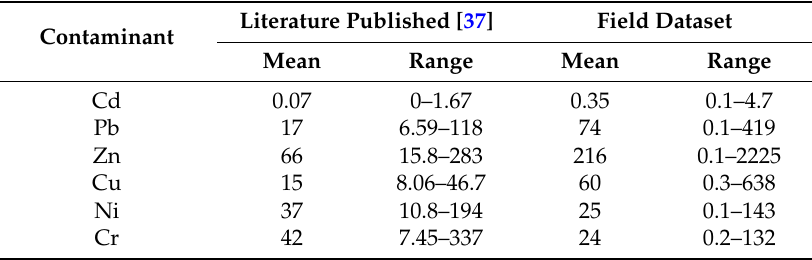
Table 5. Comparison of published and field pond contaminant concentrations.